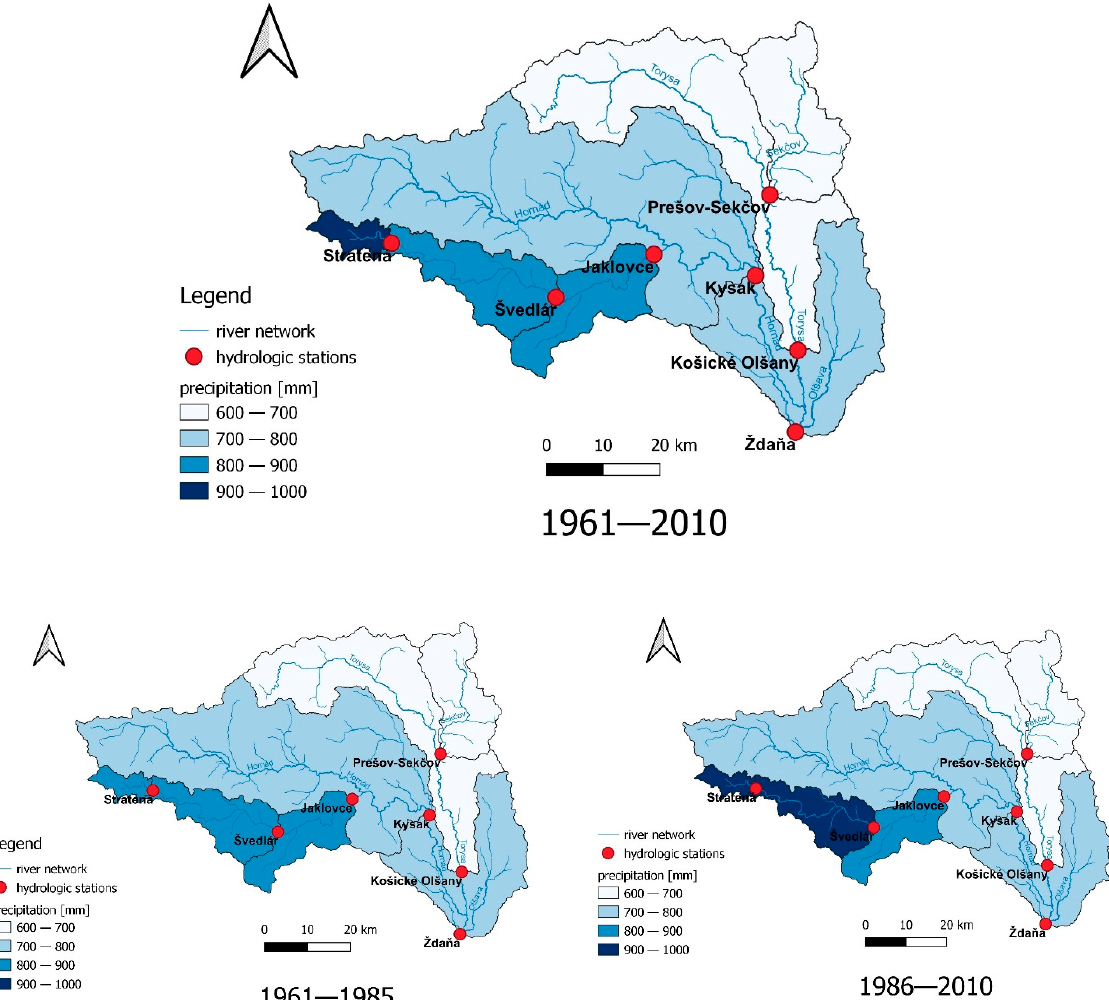
Figure 2. Distribution of annual precipitation totals in the years 1961–2010, 1961–1986 and 1986–